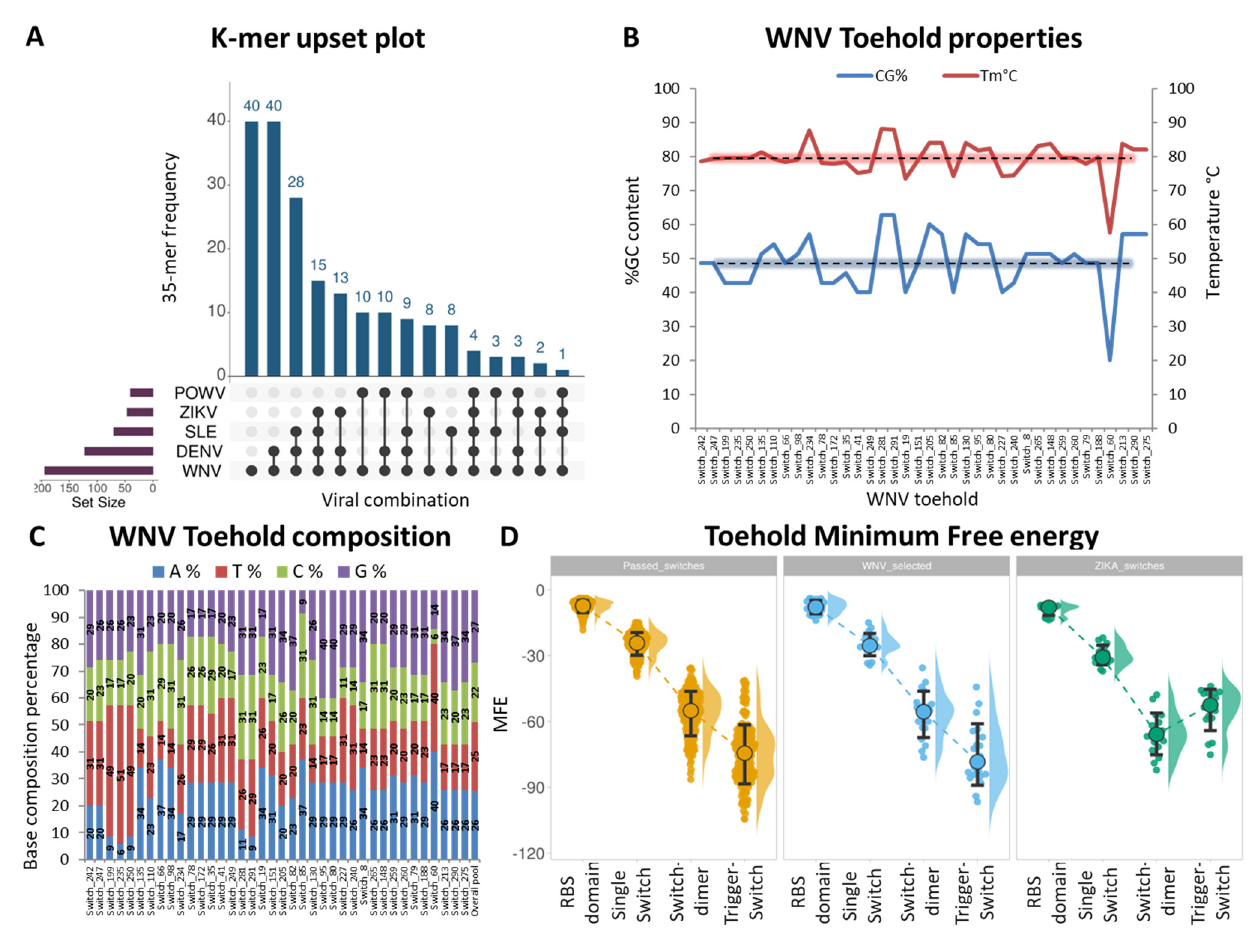
Figure 2. Design of WNV toehold switches ( A ) Upset plot highlighting the distribution of WNV 35-mer sequences across eight viruses that are related to WNV. 35-mer assignment was performed with BLAST and was scored as positive from as low as 1% of percent identity. Viruses with empty k-mer frequency are not shown. ( B ) Sequence properties of the filtered pool of 38 toeholds. Percentage of toehold sequence GC content is shown with the blue curve on the left y-axis. Melting temperature of the toehold sequence is shown with the red curve on the right axis. Dotted lines correspond to average values of the toehold pool. ( C ) Nucleotide composition of the filtered pool of toehold sequences. ( D ) Dot plot of Minimum Free Energy (MFE) calculations of four distinct toehold domains: the Ribosomal Binding Site (RBS), the single toehold switch, the toehold switch dimer and the Trigger-Switch dimer. Calculations include the total collection of 194 conserved k-mers (selected switches, shown with yellow), compared against the final pool of 38 selected WNV toeholds (blue) and the pool of 24 published ZIKV toeholds (green).